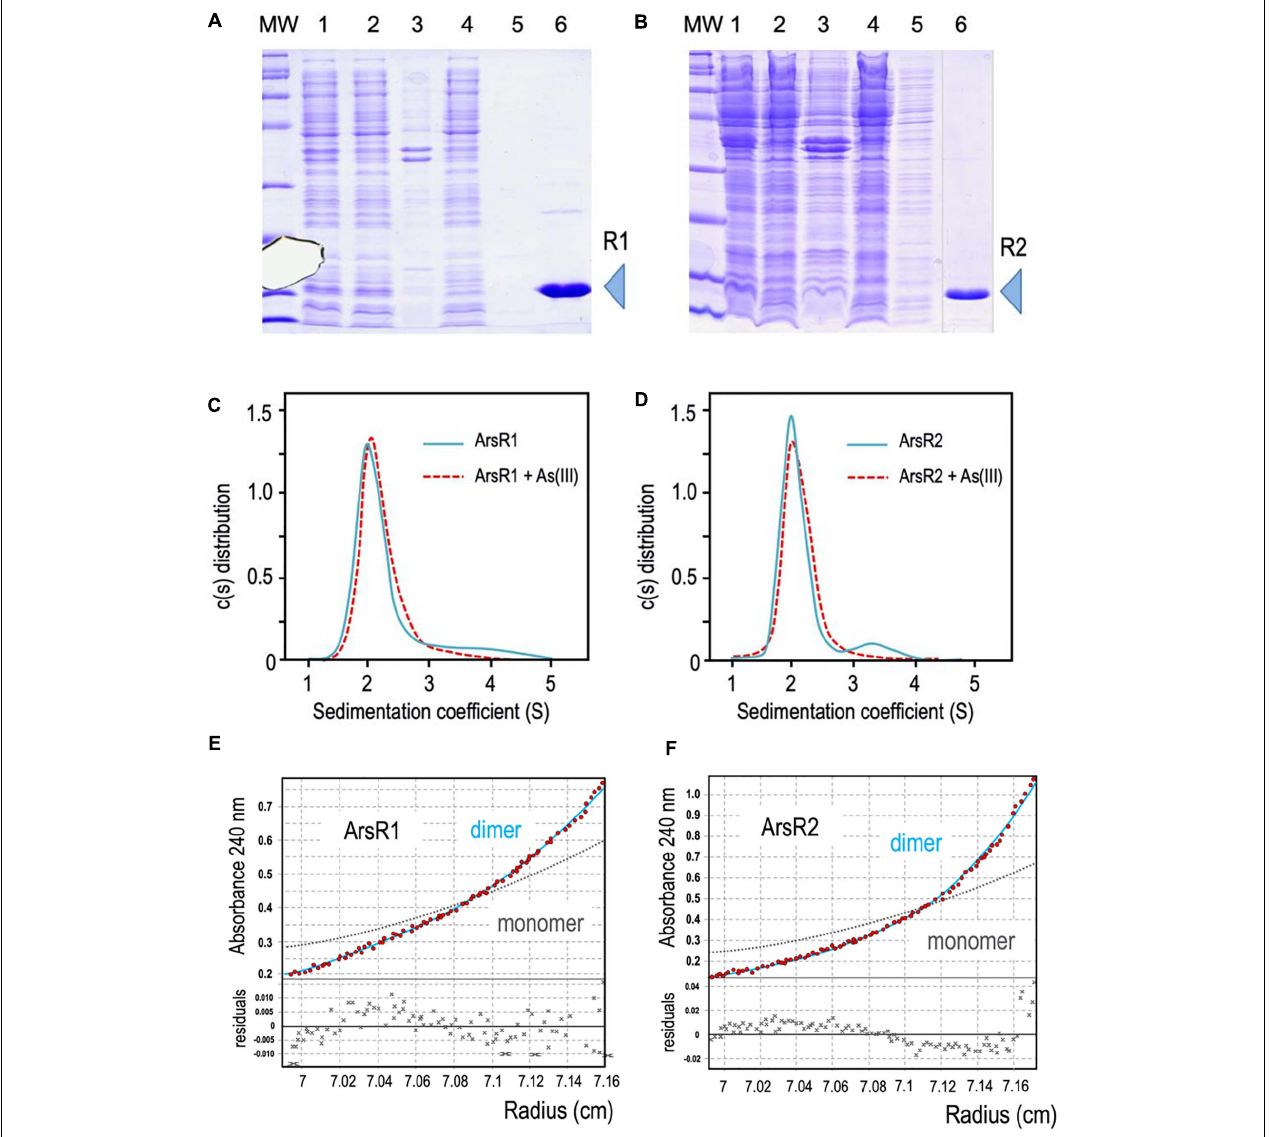
FIGURE 2 | (A,B) 6His-ArsR1 and 6His-ArsR2 expression and purification. ArsR1 and ArsR2 proteins were cloned in a pQE32 expression vector to express with a 6His tag (see section “Materials and Methods”). In both gels, MW is the molecular weight marker, lane 1, cells after expression; lane 2, supernatant after break the cells; lane 3, pellet after break the cells; lane 4, flow through after pass the supernatant by the purification column; lane 5, sample after washing the column; lane 6, elution of the purification column with imidazole (R1 and R2 point out the purified proteins ArsR1 and ArsR2, respectively). Samples were loaded in a 15% denaturing PAGE stained with Coomassie blue as shown. Note that the image of sample 6 comes from the same gel but has been pasted next to lane 5 to avoid an empty lane in between. (C,D) Oligomerization state of ArsR1 and ArsR2. Plotted data correspond to the sedimentation coefficient distribution obtained in sedimentation velocity experiments with purified 6His-ArsR1 or 6His-ArsR2 (blue continuous line) and 6His-ArsR1 or 6His-ArsR2 bound with As (III) (red dotted line). The predominant fraction of the ArsR1 or ArsR2 species (93.5%) presented both a sedimentation coefficient of 2.1 ± 0.1 S. This value corresponds to a molecular mass compatible with the theoretical values of the proteins (confirmed by sedimentation equilibrium experiments, see text), which is consistent with a dimeric form of the proteins ArsR1 (29.5 kDa) and ArsR2 (29.1 kDa). Addition of As (III) doesn’t vary the sedimentation coefficient values of ArsR1 or ArsR2, keeping the dimeric state. (E,F) Study of the oligomerization state of the ArsR1 and ArsR2 proteins in solution. Sedimentation equilibrium data ( red dots ) and the best fit analysis assuming a theoretical protein dimer ( solid blue line ) and monomer ( broken gray line ) species. The lower panel shows residuals between estimated values and experimental data for protein